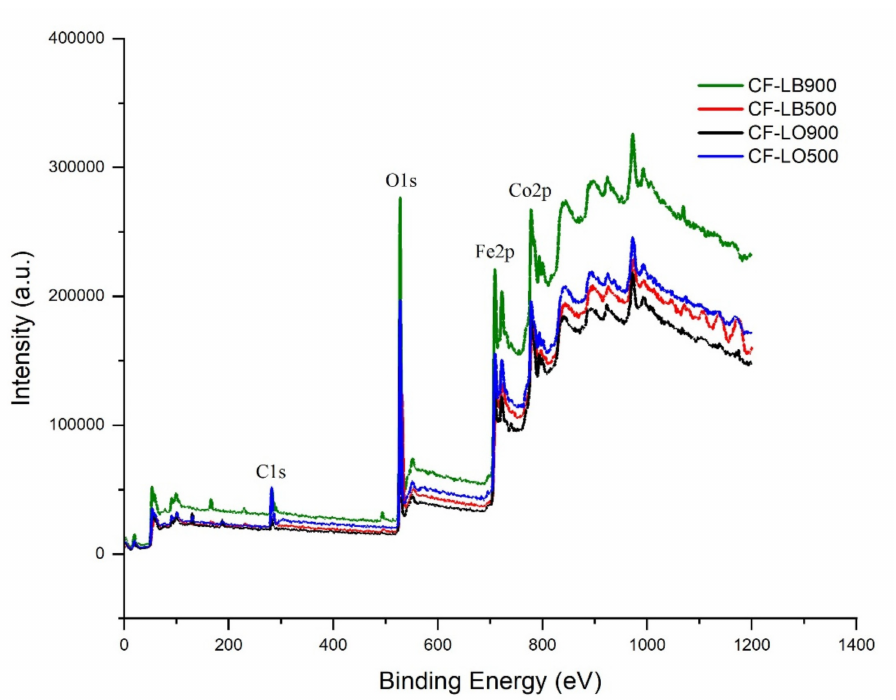
Figure 5. XPS spectra of ferrite-lignin